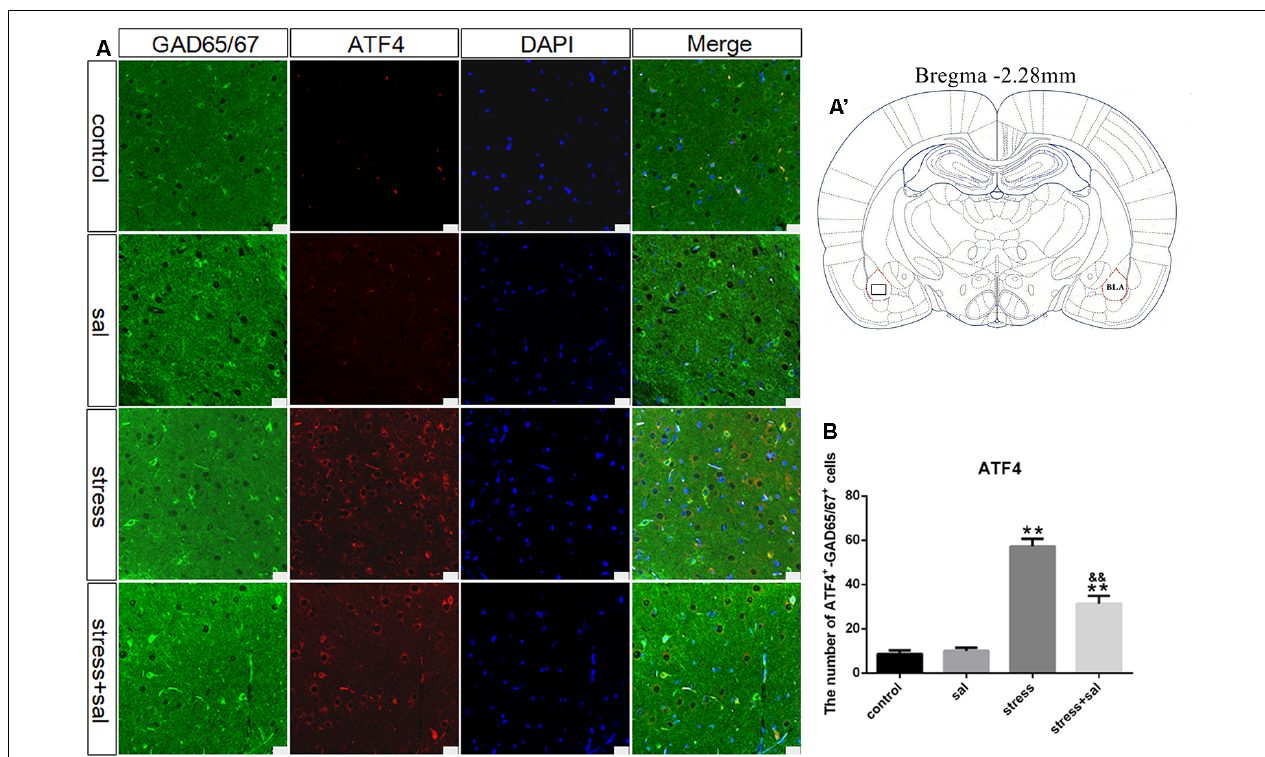
FIGURE 7 | Number of GAD65/67 positive neurons expressing ATF4 in the BLA. (A) Representative confocal images showing coronal sections of rat immunostained for GAD65/67 (green), ATF4 (red), DAPI (nuclear stain, blue) and merged (orange/yellow). Bars = 25 µ m. The analyzed region within the BLA is schematically illustrated in (A (cid:48) ) (diagram modified from Paxinos and Watson, 2007). (B) Quantitative analysis of the number of ATF4 + -GAD65/67 + cells (one-way ANOVA). Data are shown as mean ± SEM, ∗∗ P < 0.01 vs. control group, && P < 0.01 vs. stress group ( n =